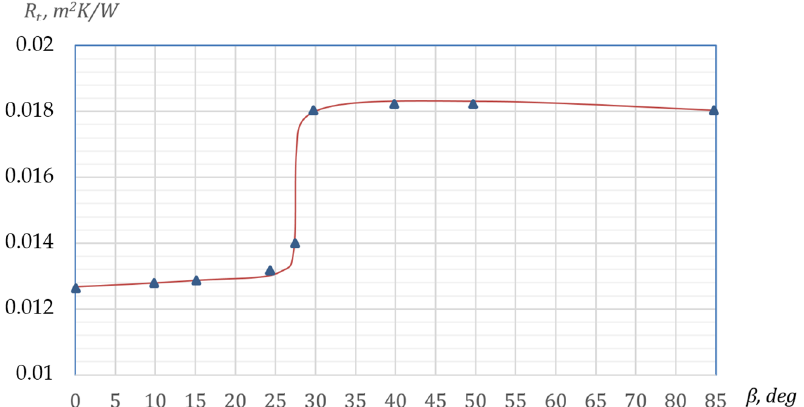
Figure 4. Change in airflow regime in the gap between the panes of a double-glazed window as a function of inclination angle β .